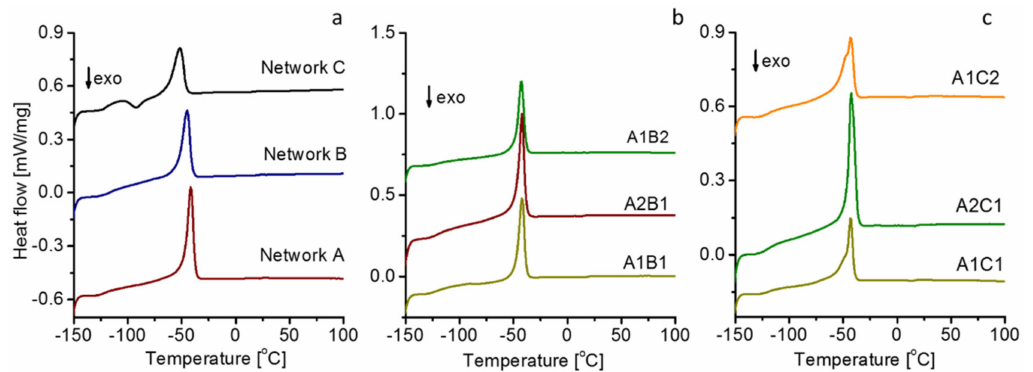
Figure 7. DSC second heating curves of the studied materials: ( a )–Reference networks: A, B and C; ( b )–AxBy series; ( c )–AxCy